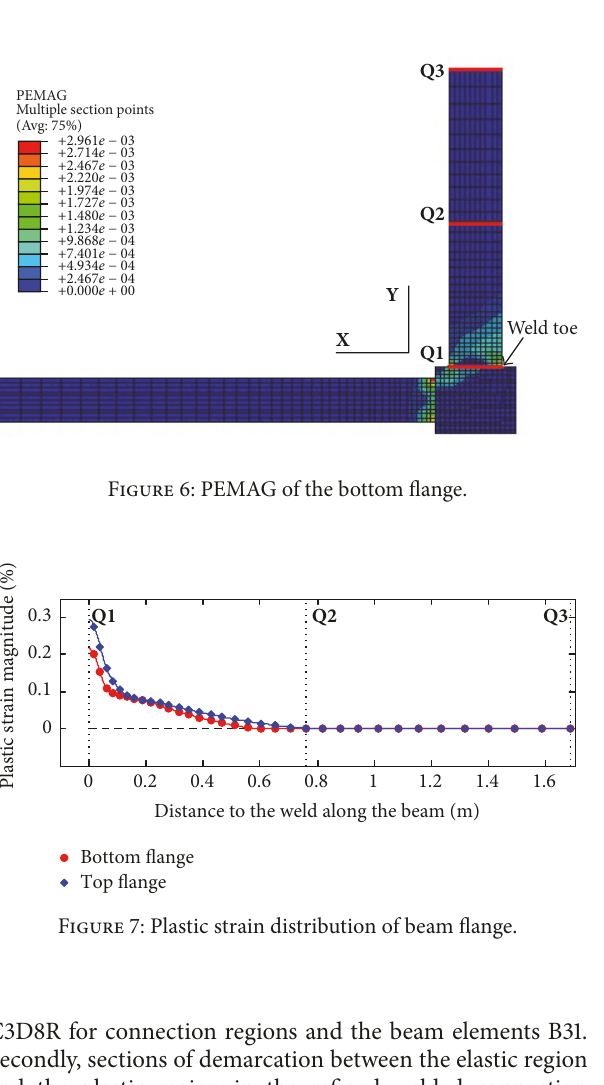
C3D8R for connection regions and the beam elements B31.